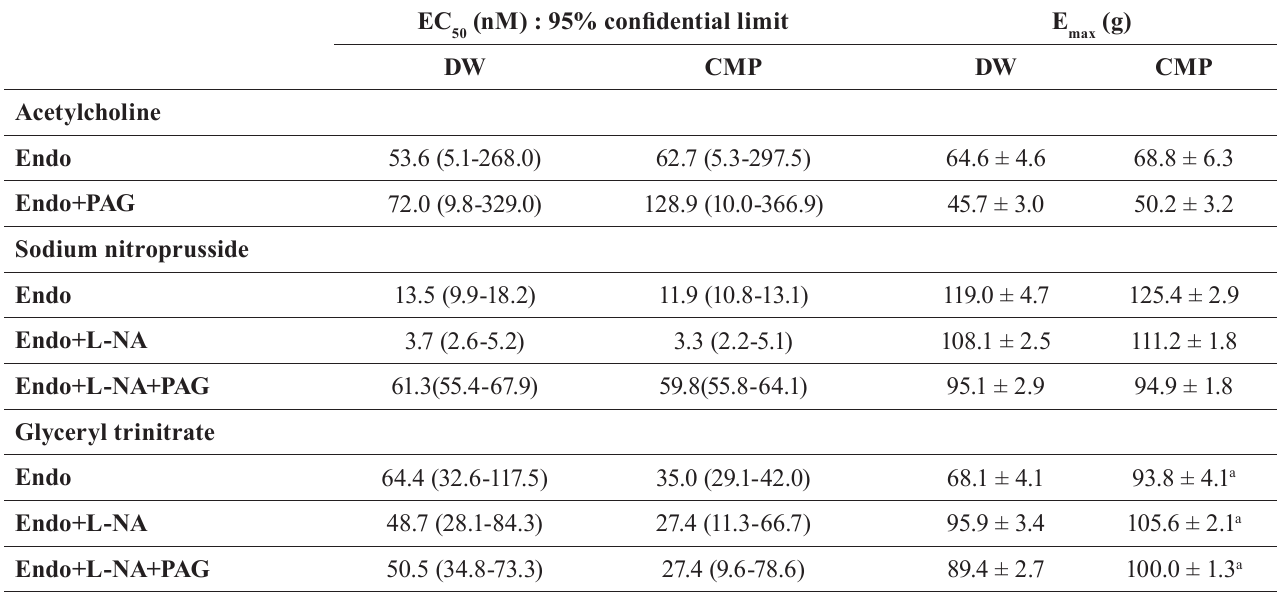
and E values 50 max